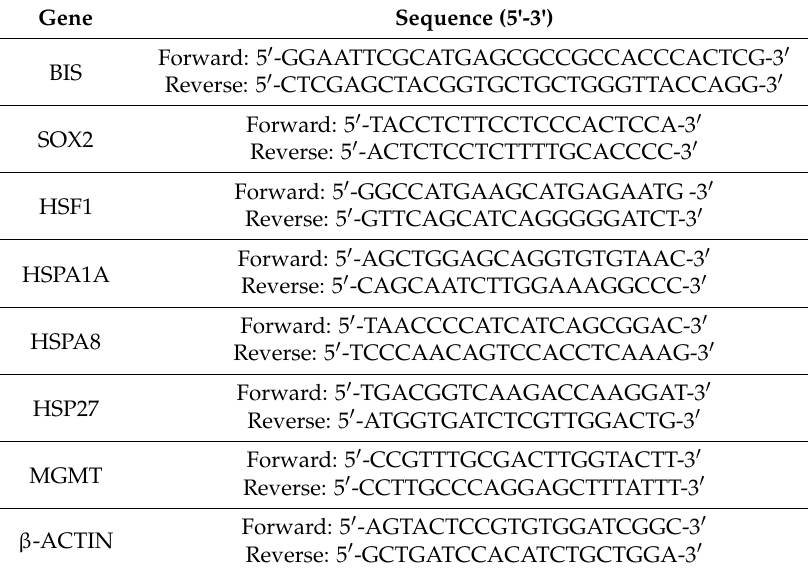
Table 1. Primers for